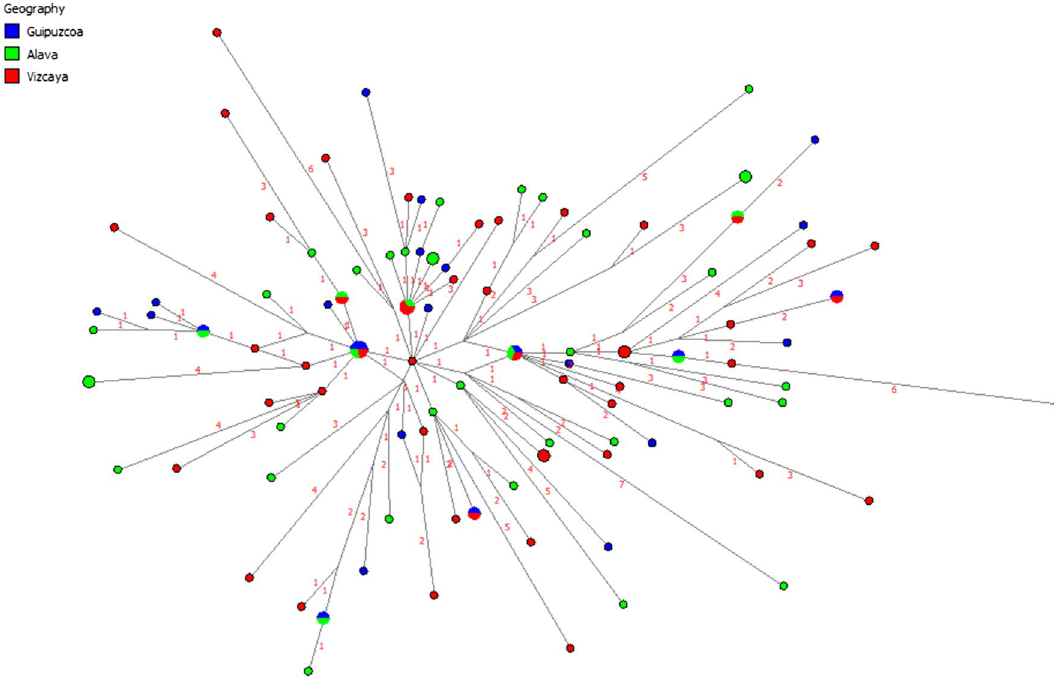
Figure 4. R1b-116 Network analysis. NETWORK 4.5.1.6 at http://www.fluxu sengi neeri